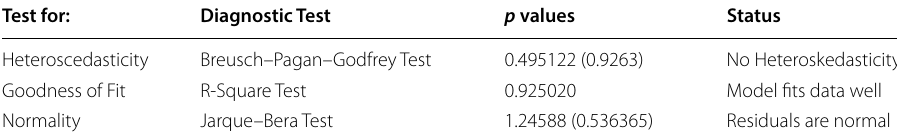
Table 7 Diagnostic test results performed on the ARDL model